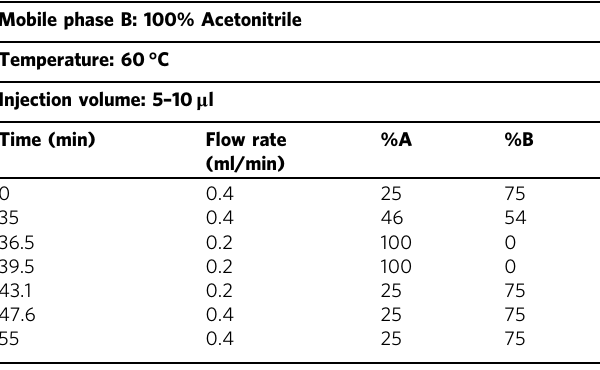
Table 2 Methods for glycan chromatograpgy in this